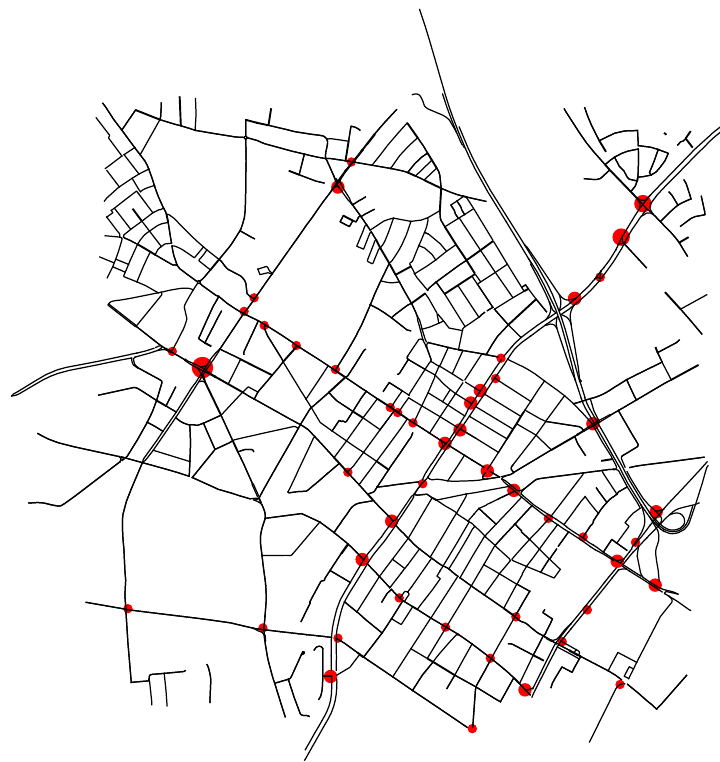
Figure 5. Representation of network edges (black lines) and intersection agents (red